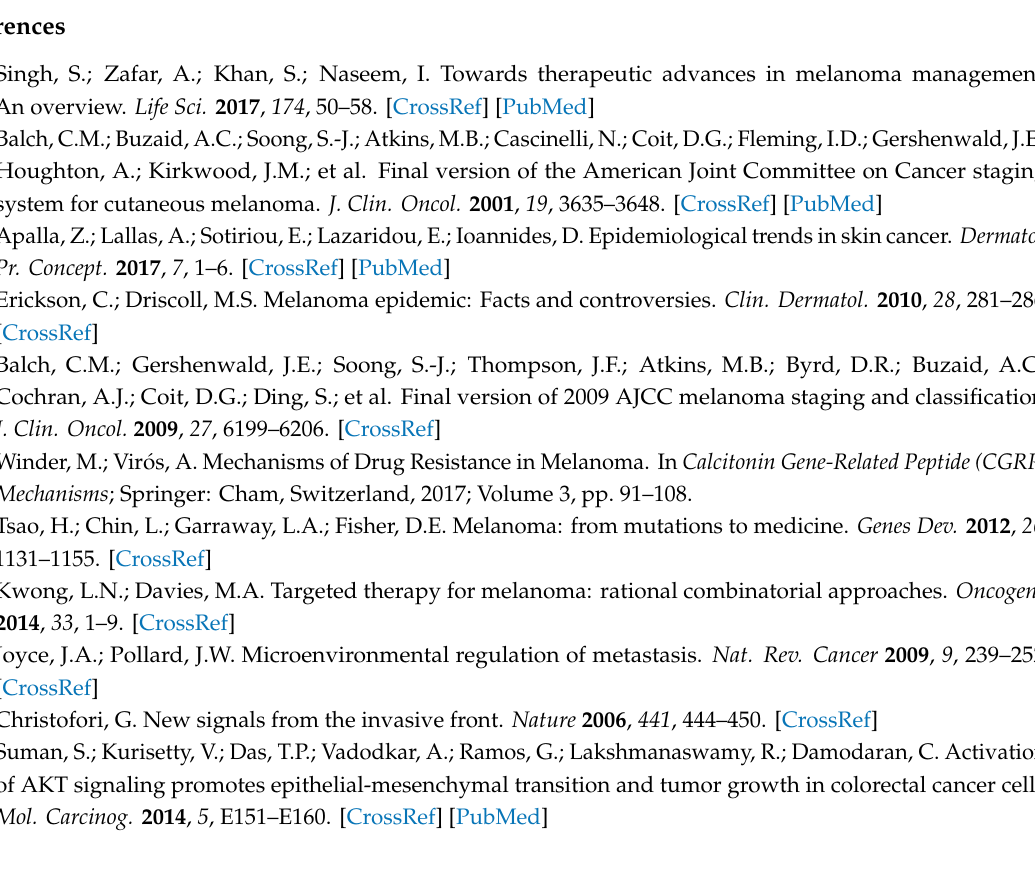
Figure S1: Flow cytometry analysis of draining lymph node (DLN) of GFP transgenic mice. Cells from DLN (DLNC) were harvested and analyzed by flow cytometry before Treg di ff erentiation. Gating was for cluster of di ff erentiation (CD)4 + T cells and analysis for CD25 + and Foxp3 +